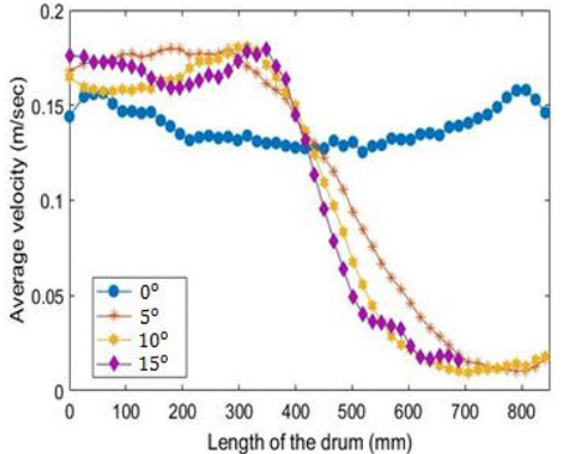
Fig. 5. Variation of the average velocity along the length of the drum for  = 0 o , 5 o , 10 o and 15 o